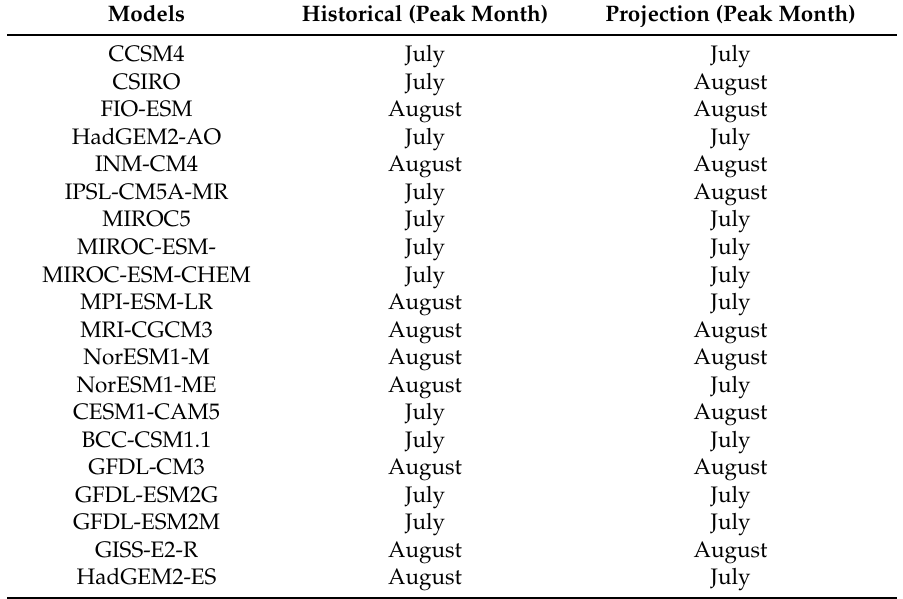
Table 2. Monsoon rainfall peak month (MRPM) of historical and projection data of models for all-India.